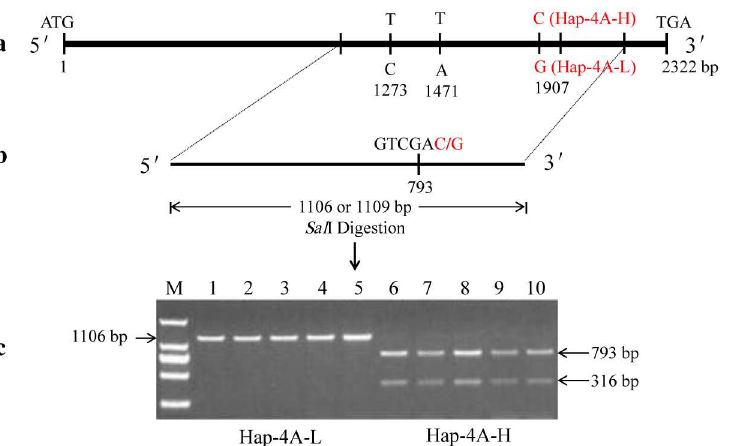
Fig 3. Functional markerdevelopment based on a SNP found in the seventh exon of TaSnRK2 . 10-4A . (a) The positionsof the Hap-4A-H and Hap-4A-L SNPs in TaSnRK2 . 10-4A . (b) SNP1907 (C-G) in the PCR product permitted the generationof different Sal I restriction fragments with lengths of 793 and 316 bp in the varieties harboringHap-4A-H, while no digestionproduct was obtained in Hap-4A-L. (c) Validationof CAPS in varieties with Hap-4A-L(1–5) and Hap-4A-H(6–10) on 1.0% agarosegel. M, marker; 1–5 are the varieties Lumai 21, Jinan 17, Yannong15, ChineseSpring, and Xiaoyan81, respectively;and 6–10 are the varieties Shannong0431, Jining 17, Shannong8355, Lumai 23 and Weimai 8,